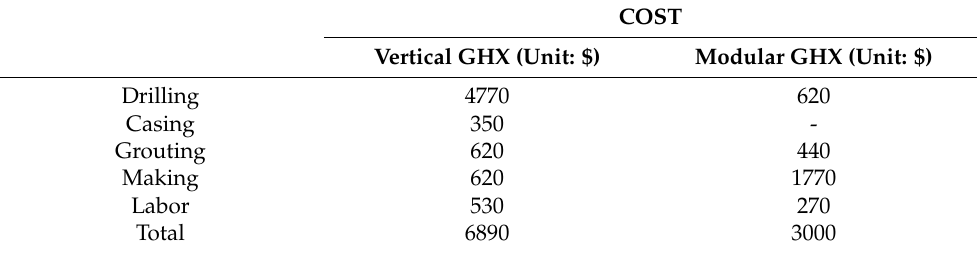
Table 2. Cost comparison between vertical GHX and modular GHX.